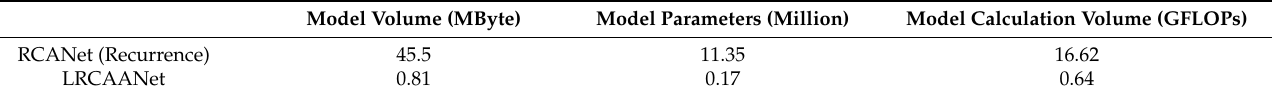
Table 7. Model complexity